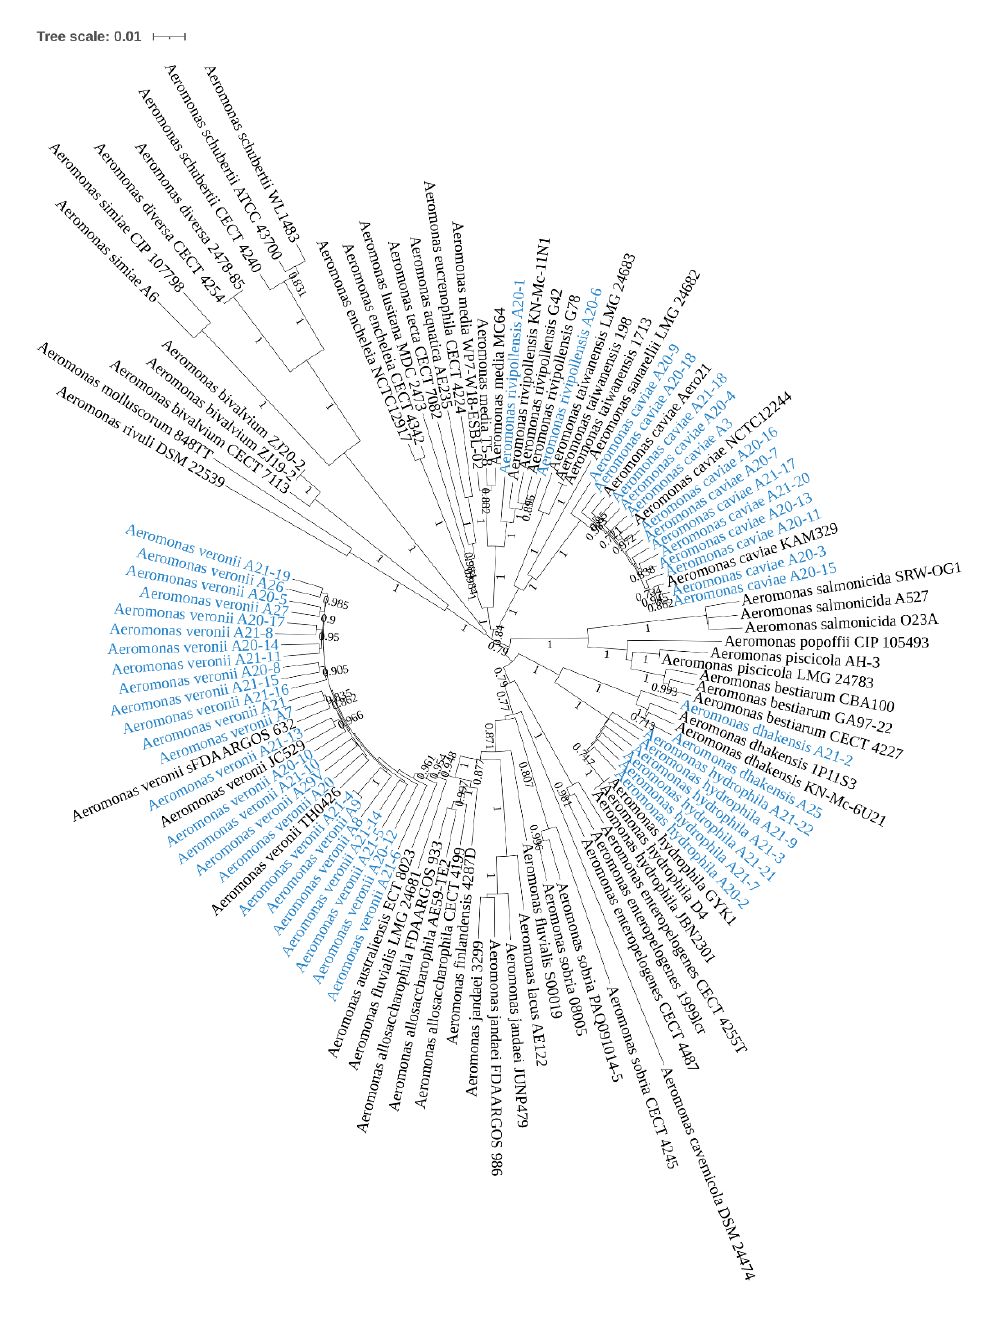
Figure 5. Identification of Aeromonas species through use of multilocus phylogenetic analysis. Aeromonas isolates were subjected to species identification based on the sequences of seven housekeeping genes, namely gyr B, rpo D, gyr A, rec A, dna J, dna X and atp D. Bootstrap values were generated from 1000 replicates. Bootstrap values between 0.7 and 1 are shown. Of the 48 Aeromonas isolates (blue) subjected to analysis, 25 isolates were Aeromonas veronii , 13 isolates were Aeromonas caviae , six isolates were Aeromonas hydrophila , two isolates were Aeromonas dhakensis and two isolates were Aeromonas rivipollensis.